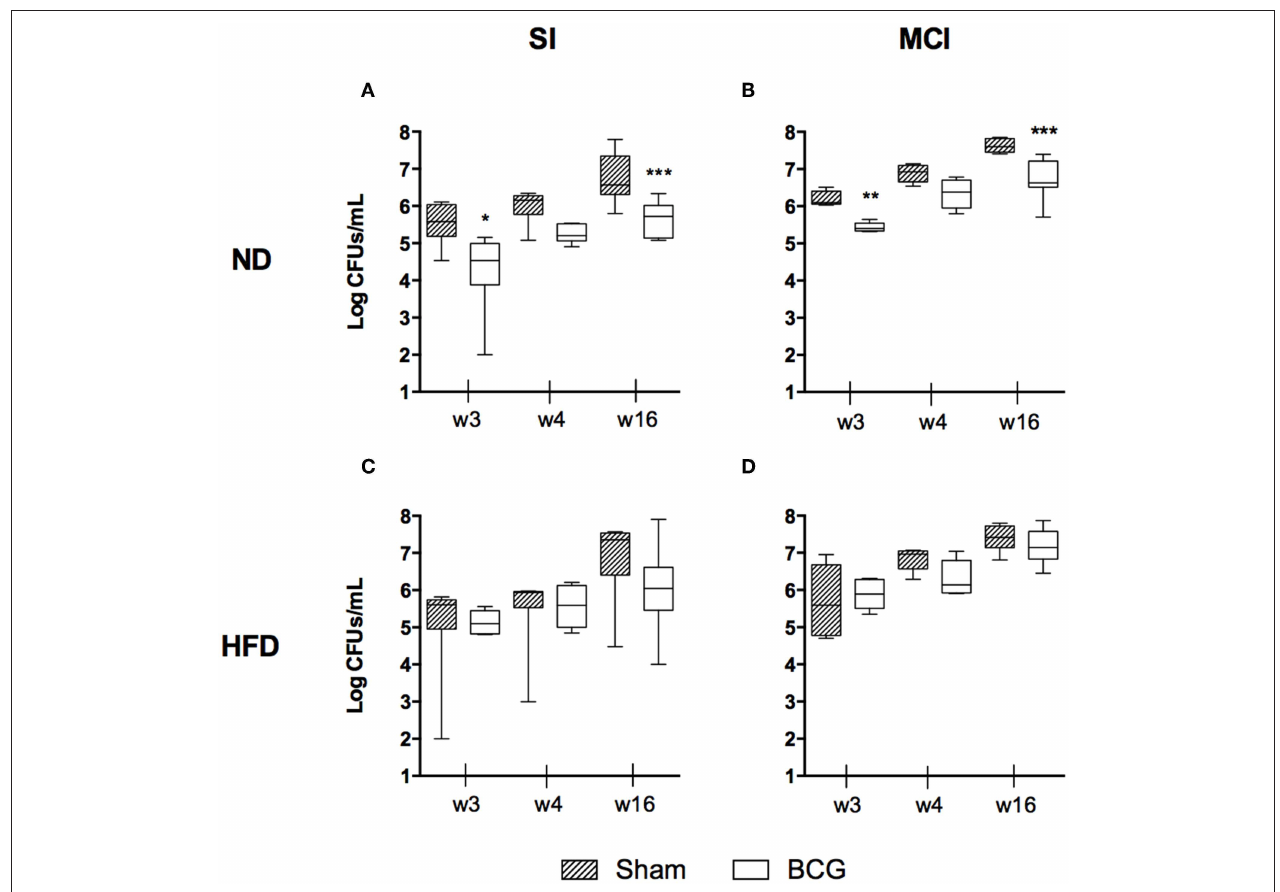
FIGURE 2 | Bacillary load progression at different end time points (w3, w4, and w16) are shown as log CFUs/ml. Each panel compares sham and BCG vaccinated groups: ND and SI (A) , ND and MCI (B) , HFD and SI (C) , HFD and MCI (D) . Box and whiskers plots show the minimum, first quartile, median, third quartile and maximum values. * p < 0.05, ** p < 0.01, *** p < 0.001; Mann–Whitney test.